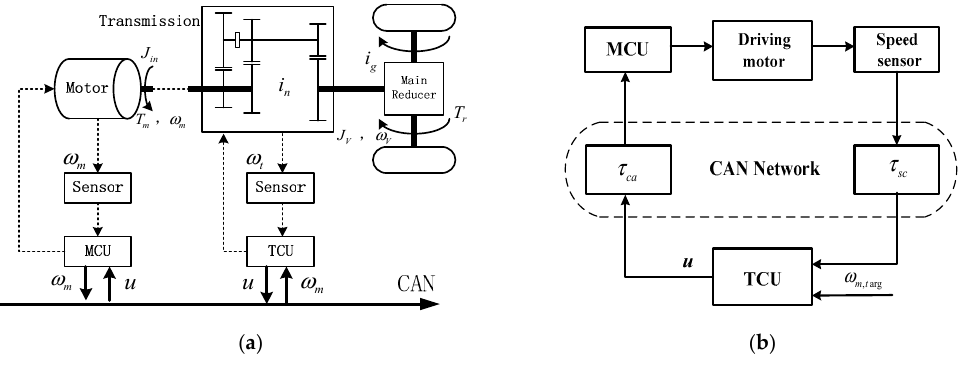
Figure 1. Integrated motor–transmission (IMT) powertrain system over a controller area network (CAN). ( a ) Structure of two-speed clutchless IMT powertrain; and ( b ) Networked control system over a CAN.